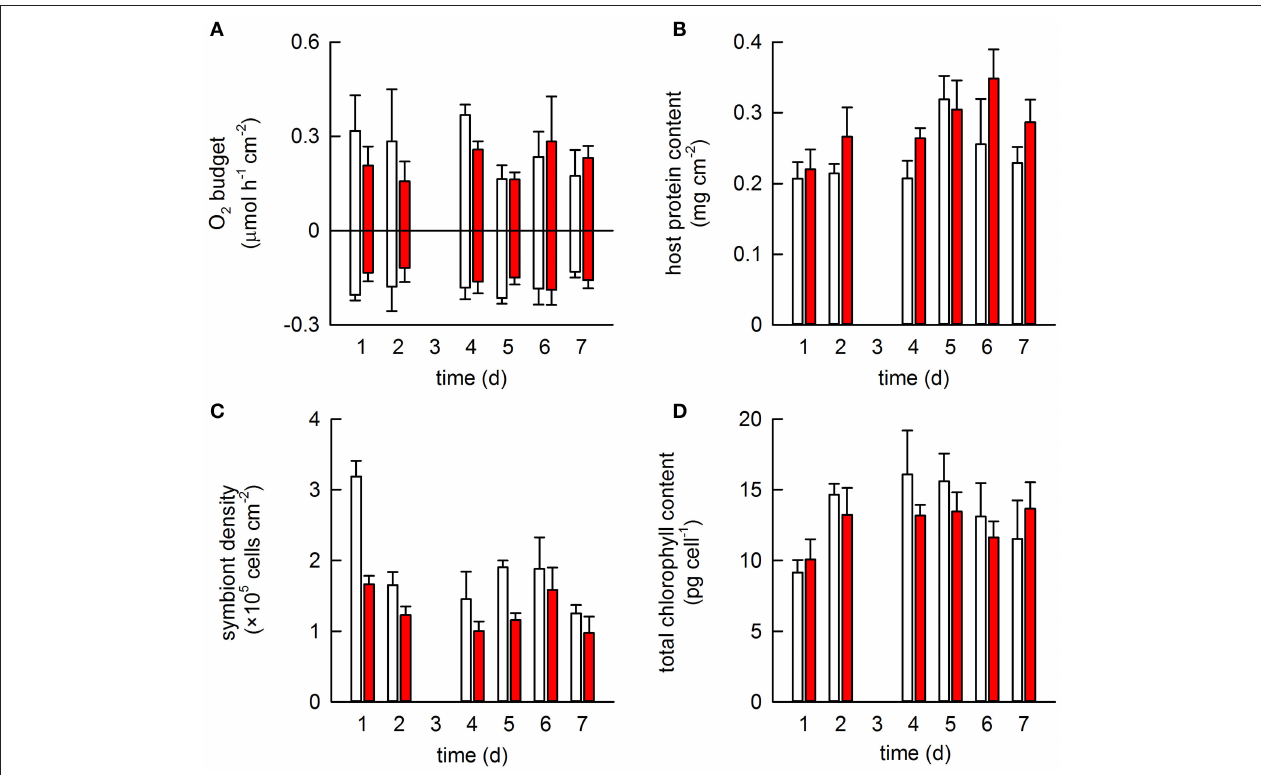
FIGURE 2 | The effect of acclimation temperature on the physiological response of Pocillopora damicornis exposed to heat stress. Four coral colonies were exposed to two different acclimation temperatures for 2 weeks: ambient (26.8 ◦ C; white) and warm (28.2 ◦ C; red) in a paired design. All were then exposed to heat stress (29.5 ◦ C) for 1 week. One fragment from each colony and each acclimation treatment was sampled daily (except for day 3, when data was lost) and used to monitor a suite of physiological measurements: (A) gross photosynthesis and respiration; (B) host protein content; (C) symbiont density and (D) chlorophyll content per symbiont cell. Bars represent mean ± SE ( N =